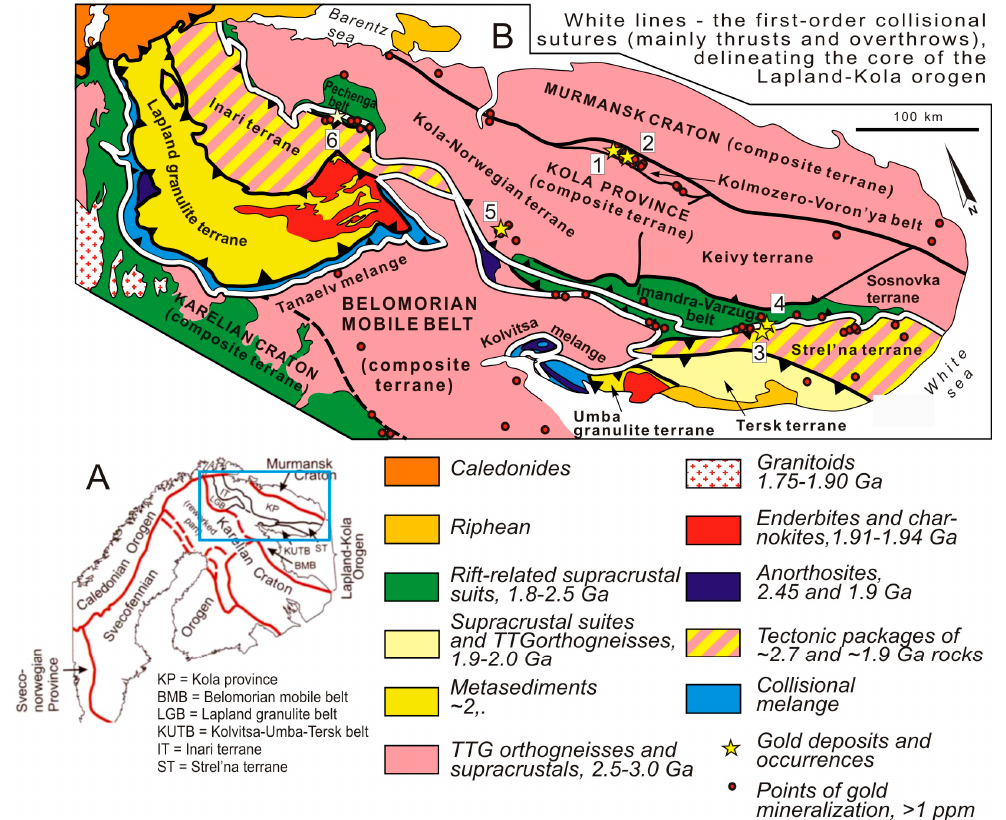
Figure 2. Schematic tectonic map of the Fennoscandian Shield ( A ) and of the Kola region and adjacent regions of Northern Fennoscandia ( B ) [15].